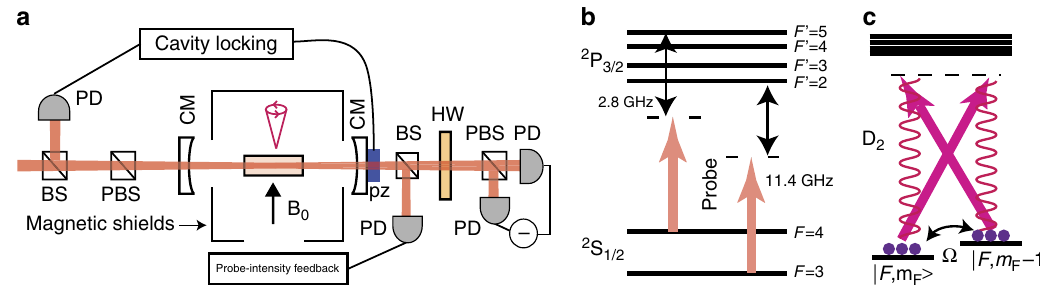
Figure 4 | Proof-of-principle experiment. ( a ) Schematic representation of the proof-of-principle experiment. ( b ) The D2 transition probed in the proof-of-principle experiment. ( c ) Effective coupling scheme for the Faraday interaction 13 . The strong probe beam (straight arrows) is polarized perpendicular to the applied field and can thus drive s þ and s (cid:3) transition. An atom scattered between two different m F levels results in a p polarized photon (wiggly lines), orthogonal to the drive. In the weak probing limit, the measurement of the Faraday rotation angle is thus equivalent to a heterodyne measurement of the emitted light in the Raman transition with the probe pulse acting as a local oscillator. BS, beam splitter; CM, cavity mirror; PBS, polarizing beam splitter;